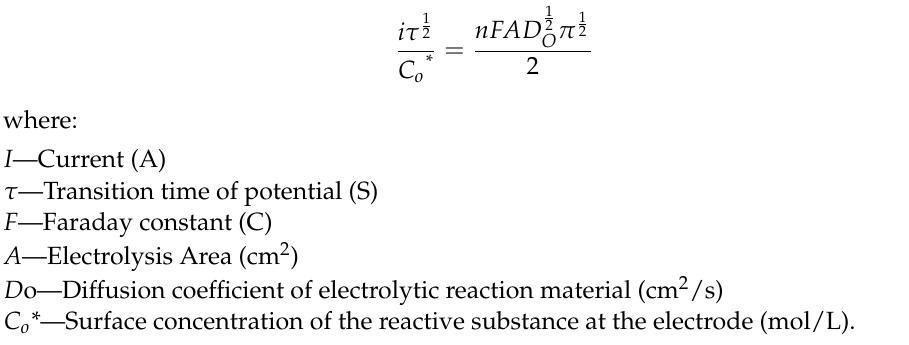
Figure 15. Current acquisition diagram; ( a ) sampling current with pulse on 750μs and pulse off 180μs; ( b ) sampling current with pulse on 1000μs and pulse off 200μs.